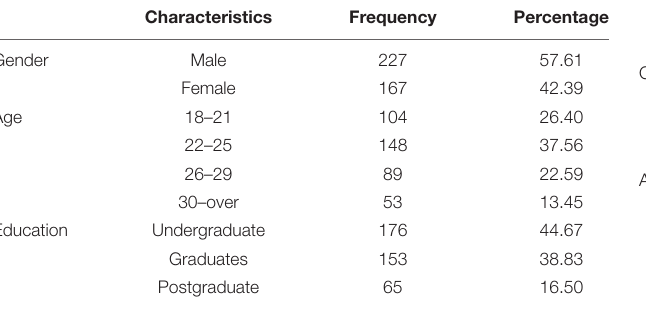
TABLE 1 | Characteristics of respondents.